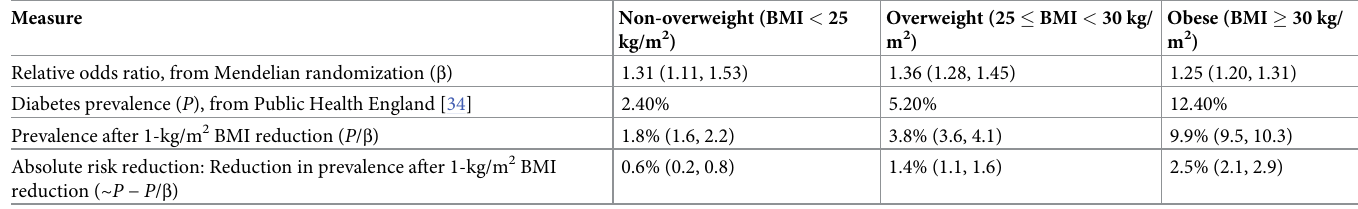
Table 3. Relative versus absolute risk reduction across BMI categories.